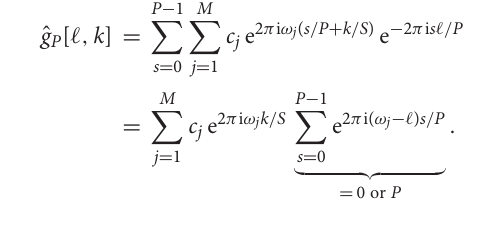
Algorithm 2.8 (MUSIC) O ( N 3 Algorithm 2.9 (ESPRIT) O ( N 3